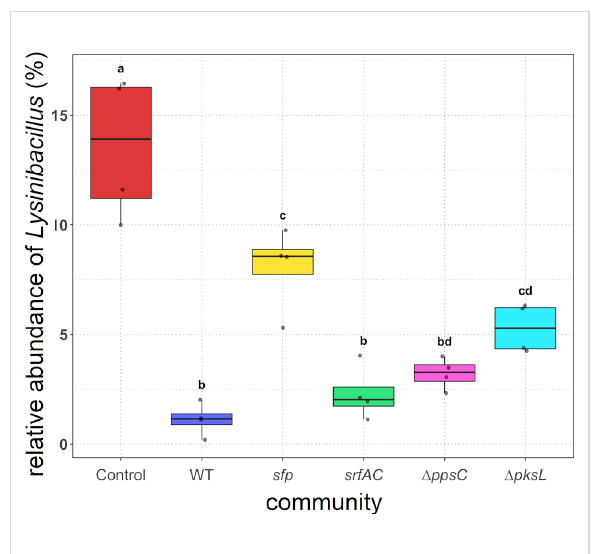
Figure 6: The relative abundance of Lysinibacillus in the untreated (“Control”) and treated mock communities with either B. subtilis wild type (“WT”), the NRP-deficient strain sfp , the surfactin mutant srfAC , the plipastatin mutant ∆ ppsC , or the bacillaene mutant ∆ pksL , coculti- vated for 48 h. The points represent the abundance in each replicate. Treatments with different letters are significantly different ( P ≤